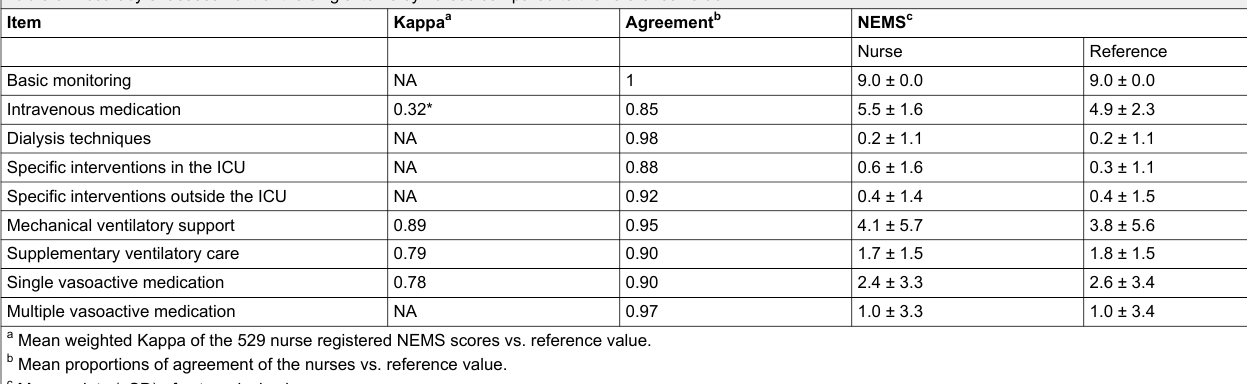
Table 3: Accuracy of assessment of the single items by nurses compared to the reference value. Item